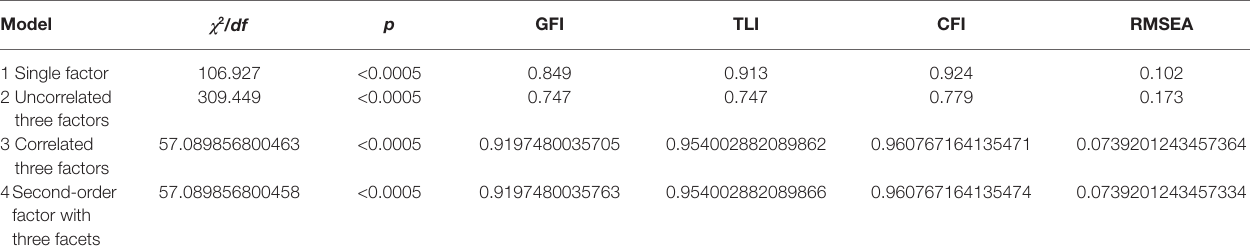
TABLE 2 | Model fit indices of UWES-S scale measuring L2 engagement.